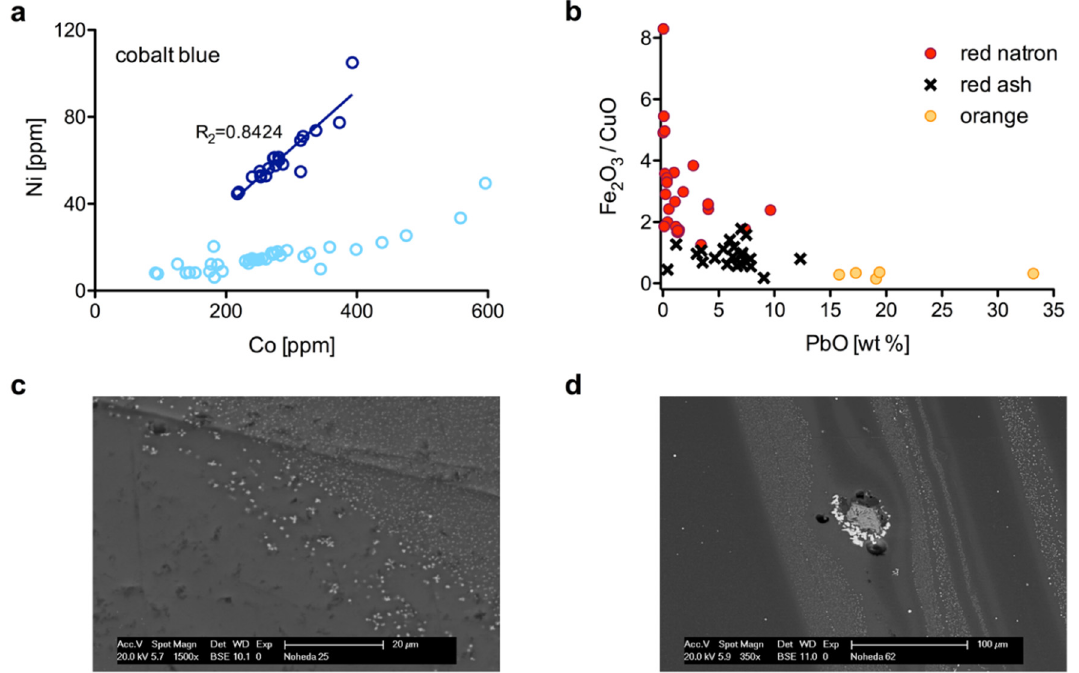
Figure 7. Elements and oxides responsible for the colors of the tesserae. ( a ) Two different correlations of Co versus Ni in the cobalt blue tesserae indicat the use of two different cobalt-bearing minerals; ( b ) Fe 2 O 3 / CuO compared to PbO in the red (natron and plant ash) and orange glasses separate the three groups in terms of coloring recipes; ( c ) dendritic cuprous oxide crystals (Cu 2 O) in an orange tessera; ( d ) relic of metallurgical slag, showing copper particles separating from the slag (light grey) and partially dissolved in the glass matrix; black structures are air